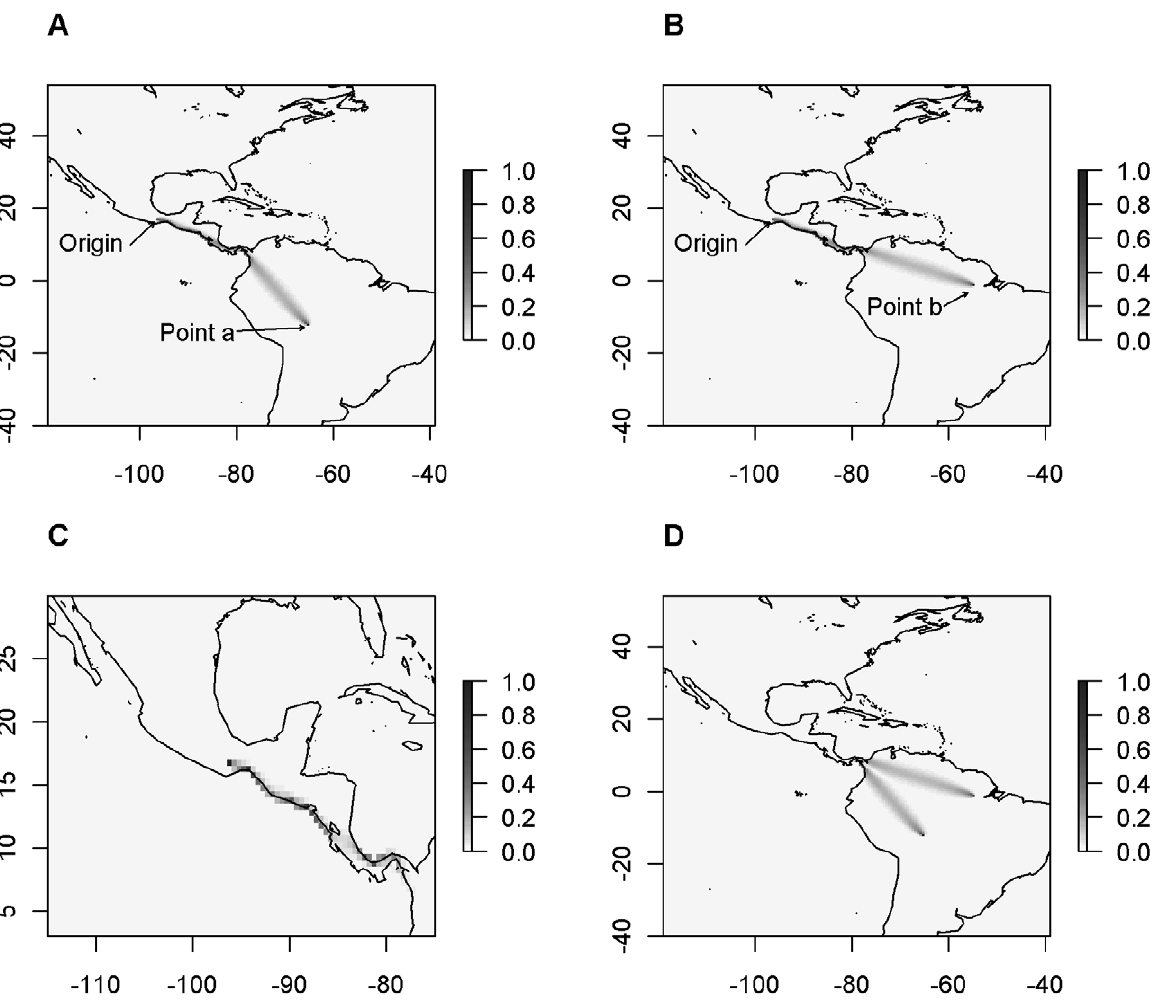
Figure 1. Example of trajectory overlap and divergence calculation for two populations. Both populations are from South America (point locations A and B). The origin of the crop is in Mexico. A. Probability of passage from origin to location a. B. Probability of passage from origin to location b. C. Overlap of the trajectories. D. Divergence of the trajectories.